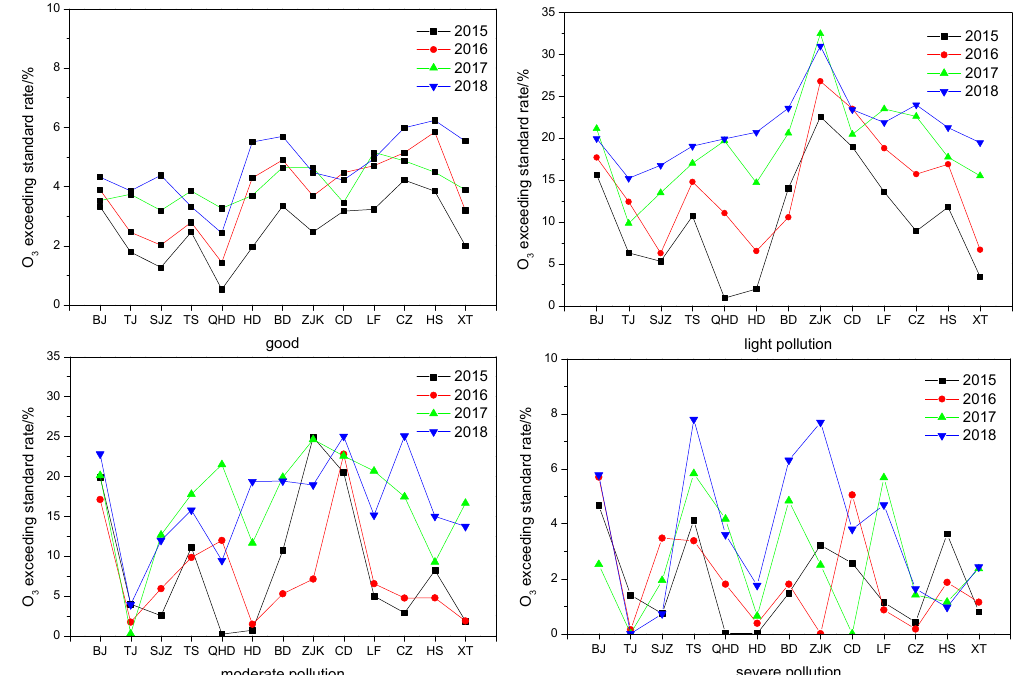
Figure 10. Annual exceeding standard rate of O 3 concentrations at different air quality levels.